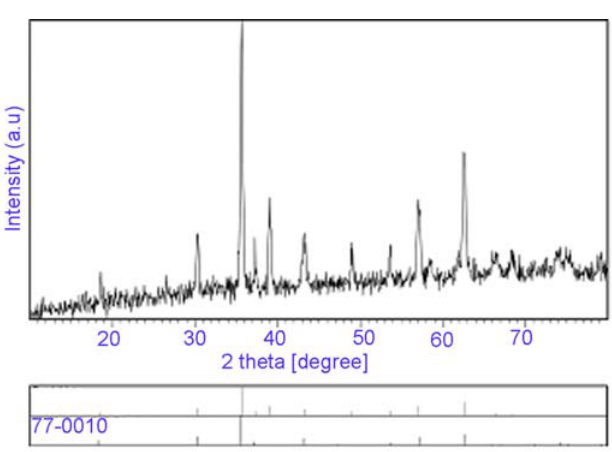
Fig. 3. XRD pattern of CuFe